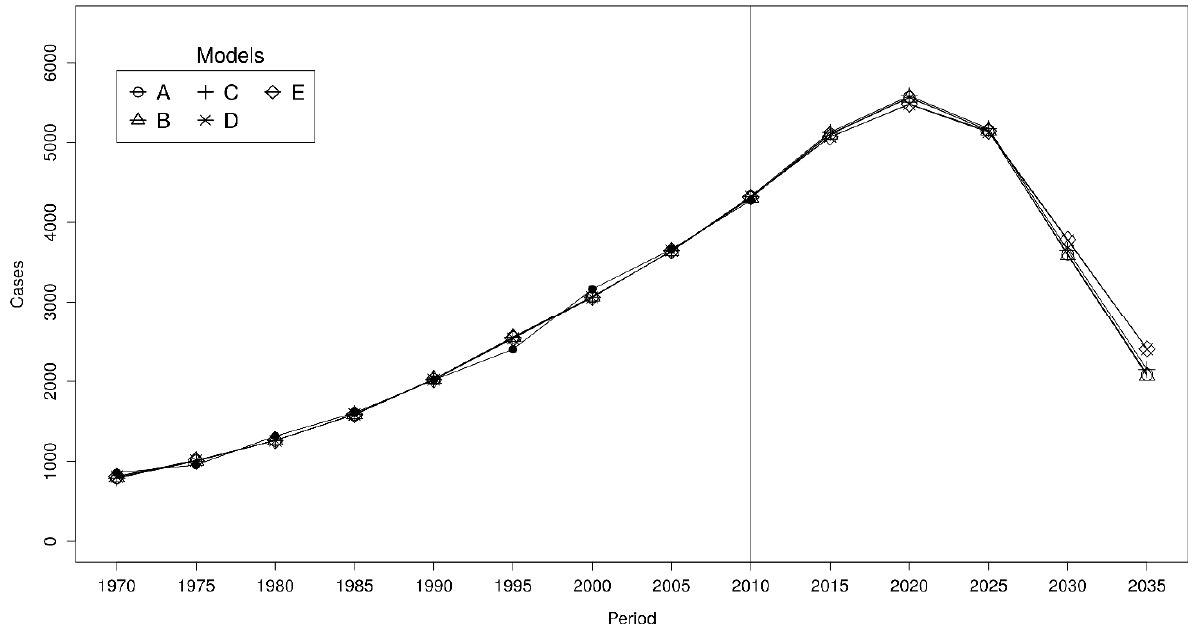
Figure 1. Comparisons of predictions based on the five best performing models. Model A assumes an age range for exposure equal to 20–70 years and a post-ban asbestos exposure equal to 10% of that estimated in 1992. Models B, C, D, and E assume (20–70 years; 5%), (20–70 years; 20%), (20–65; 10%), and (20–65; 5%), respectively. Black dots indicate observed cases.